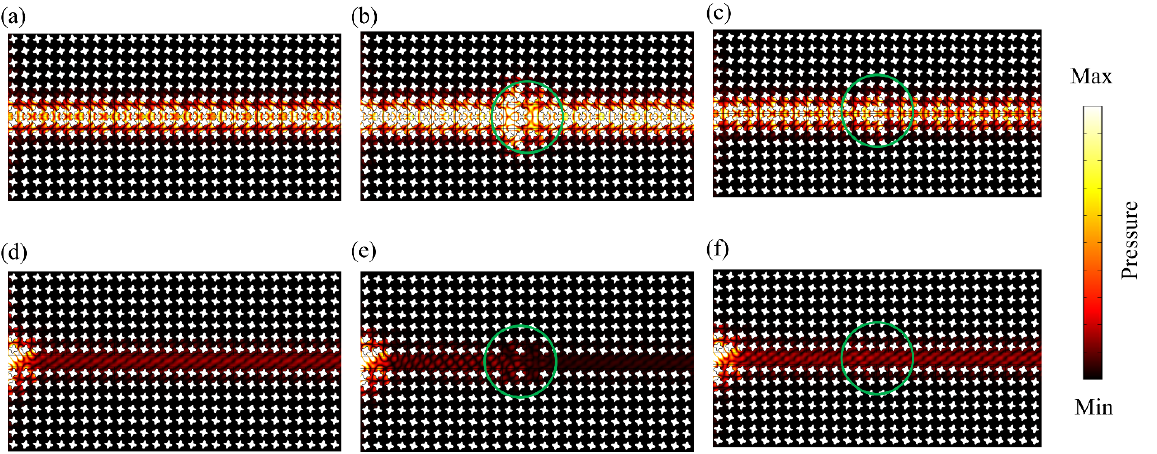
Figure 4. ( a ) Simulated acoustic pressure field in the valley-like structures without defects. ( b , c ) Simulated acoustic pressure field with cavities and disorders, where the incident frequency of the acoustic wave is 16 kHz (within the bulk bandgap). ( d ) Simulated acoustic pressure field of the